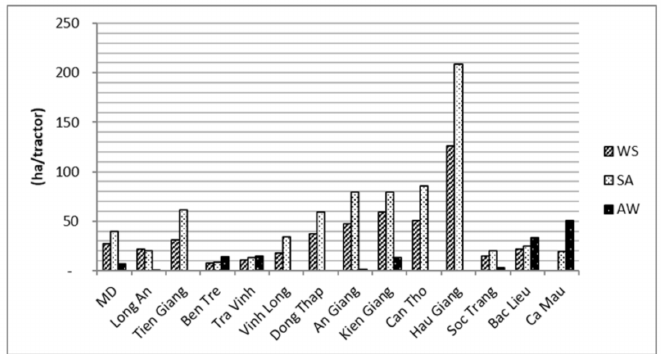
Figure 7. Average rice cultivation land per tractor.by crop season and province in Mekong Delta; WS: Winter–Spring; SA: Summer–Autumn; AW: Autumn–Winter; MD is the average of all 12 provinces